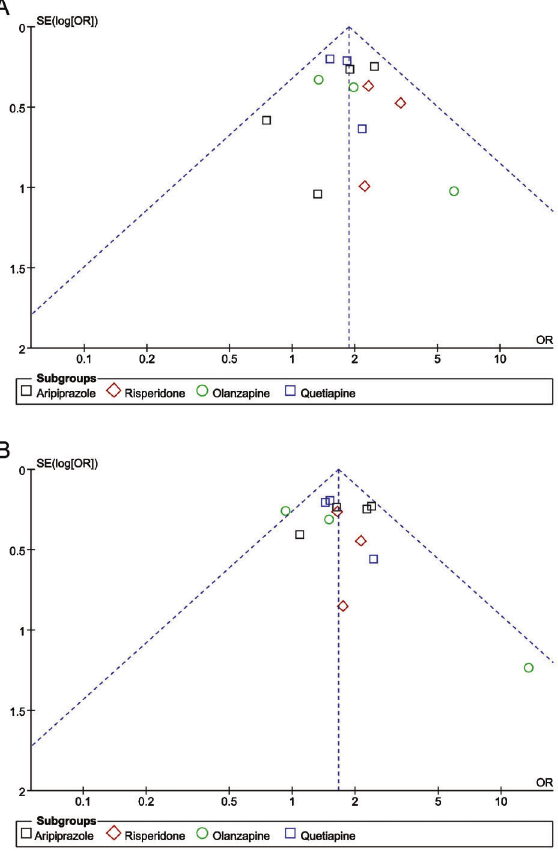
Figure 8. Funnel plot of adjunctive atypical antipsychotics in major depressive disorder for remission rate ( A ) and response rate ( B ). Funnel plot was the odds ratios (OR) vs the standard error [SE(log)OR] in trials.